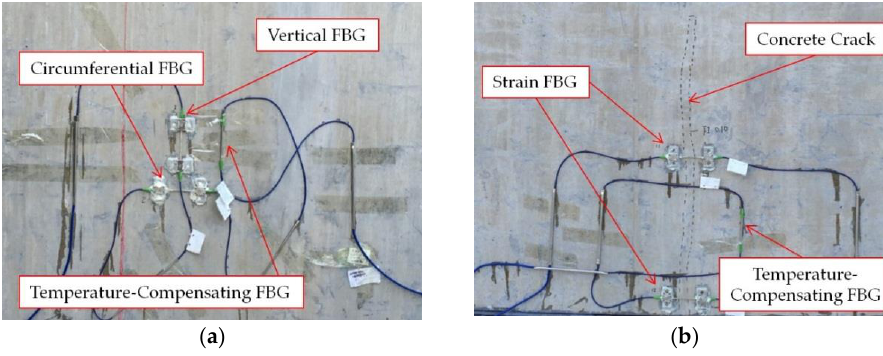
Figure 2. Two types FBG measuring points. ( a ) General measuring point; ( b ) Crack measuring point. Appl. Sci. 2017 , 7 , 419